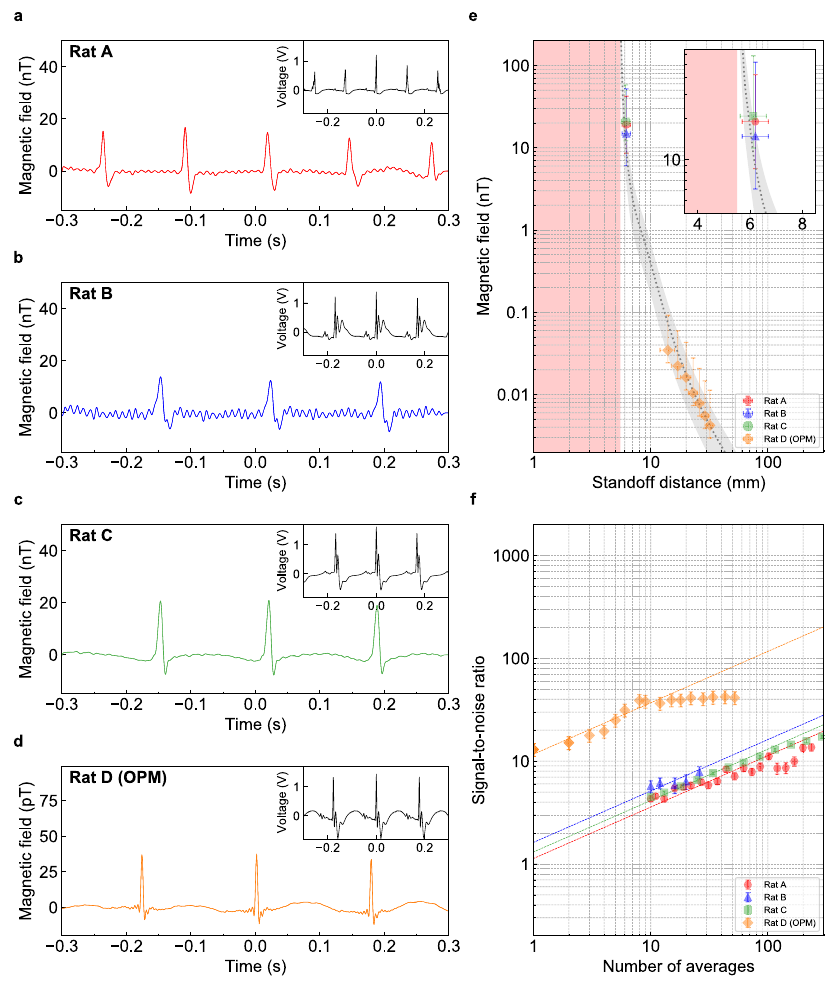
Fig. 2 Time-domain cardiac magnetic fi eld signal. a – d Typical time-domain magneto-cardiac signal from rats A, B, C, and D, detected with the solid-state quantum sensor (rats A – C) and an optically pumped magnetometer (OPM) (rat D). The insets show electrocardiography (ECG) signals recorded simultaneously. The peaks correspond to the R-wave, the repetition rate of which matches that of ECG. e Dependence of the cardiac magnetic fi eld strength at the R-wave peak on the standoff distance d from the heart centre to the sensor. The vertical error bars re fl ect an indeterminacy of the sensor position in the XY direction relative to the point of the maximal magnetic fi eld. The horizontal error bars represent the systematic error due to an inaccuracy in measuring the standoff distance. The grey dashed line is the magnetic fi eld calculated from a multiple-current-dipole model with a total dipole Q ¼ ð 1 : 4 ± 0 : 2 Þ ´ 10 3 μ A mm ( fi tted). The grey shaded area also re fl ects an indeterminacy of the sensor position. The pink shaded area represents the heart domain. f Dependence of the measurement signal-to-noise ratio (SNR) on the number of averages of the cardiac pulse N ave . Dashed lines show the fi tted model SNR / N 1 = 2 . For the solid-state quantum sensor (rats A – C), square-root dependence is observed. By contrast, for the OPM, the SNR saturates at ave ~40, possibly due to the residual environmental magnetic fi eld that cannot be removed by the magnetic shield. Error bars are calculated from the signal, measurement noise, and the number of